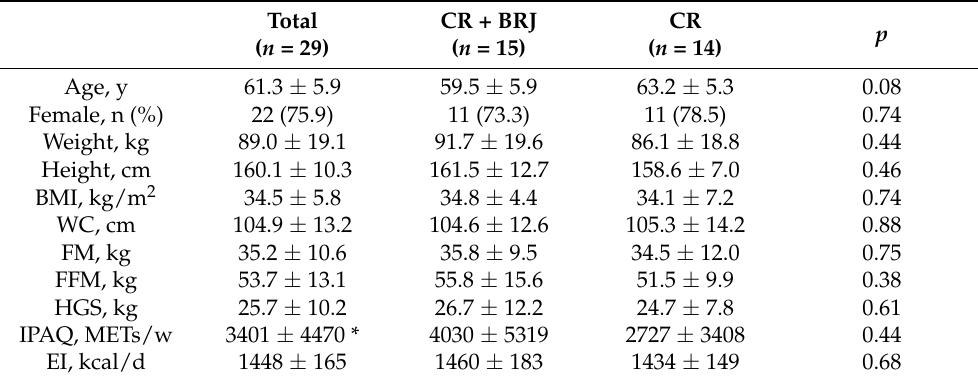
Figure 1. Flowchart showing the number of participants from the enrolment to the analysis. CR, caloric restriction; BRJ, beetroot juice. Table 1. Baseline characteristics.